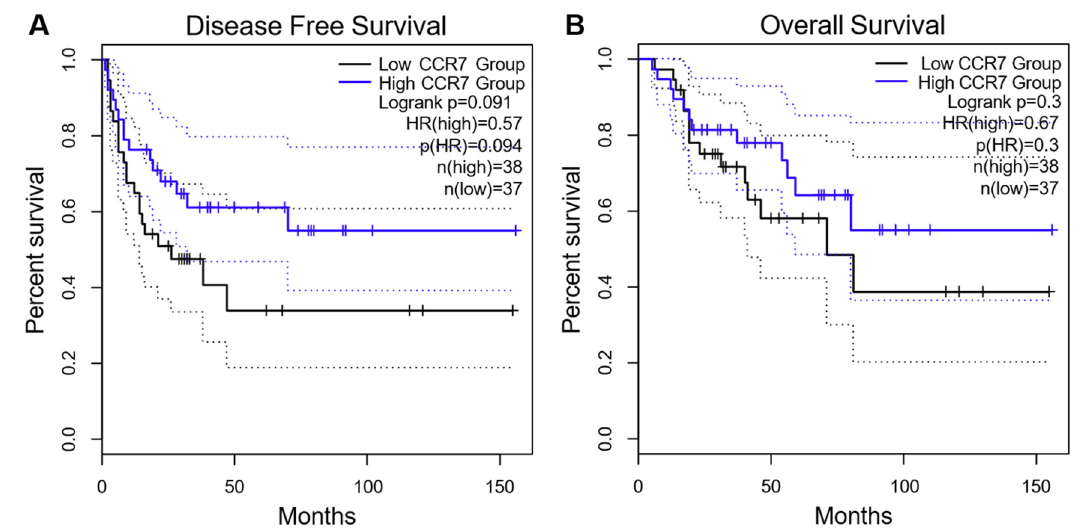
Figure 6. Disease free survival ( A ) and overall survival ( B ) of patients with adrenocortical carcinoma based on CCR7 mRNA expression using publicly available data sets. KM-plots were generated using GEPIA2 (www.gepia2.cancer-pku.cn/; accessed 22 August 2021). HR = Hazard Ratio. Table 1. Characteristics of the ACC patients with analyzed primary tumors reported in this study.